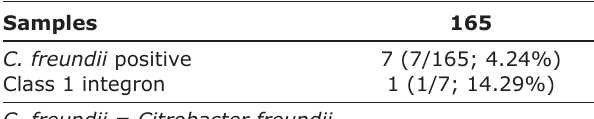
Table-1: Prevalence of C. freundii from laying chickens in Blitar,